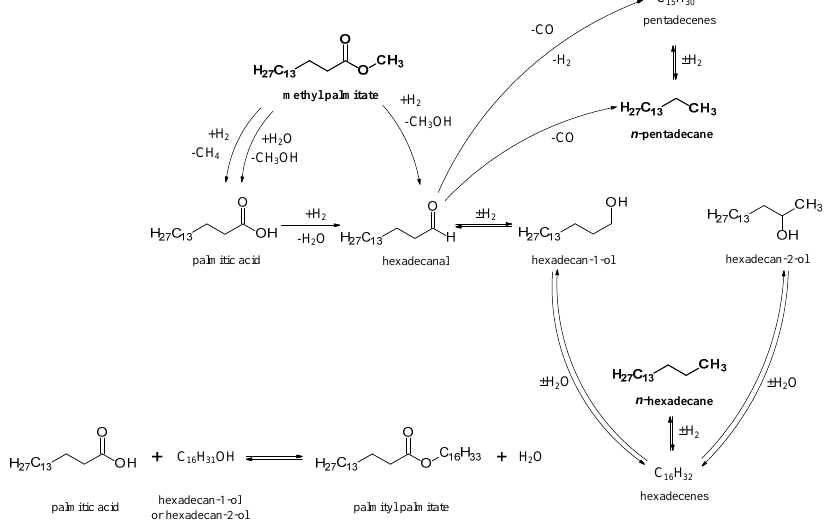
Figure 5. Proposed reaction network over silica ‐ supported nickel phosphide catalysts.